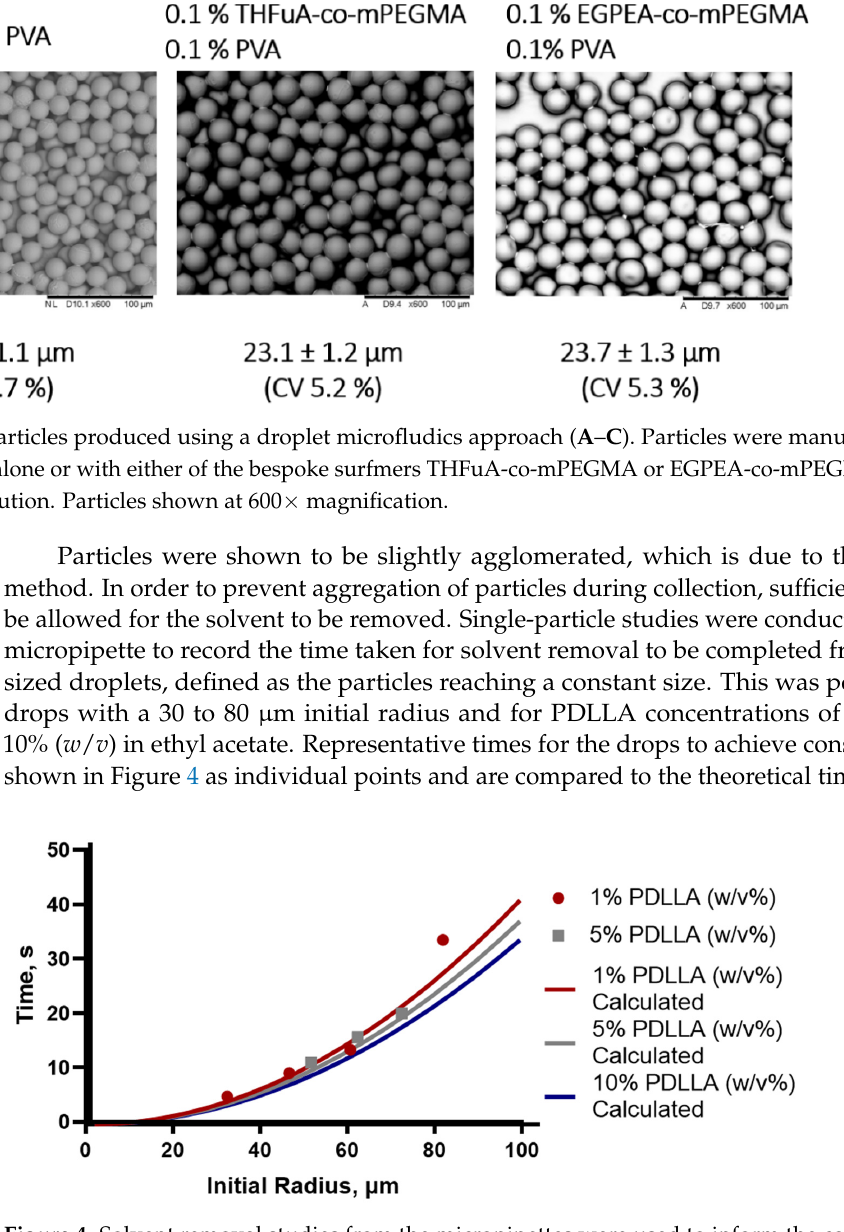
Figure 4. Solvent removal studies from the micropipettes were used to inform the collection vessel properties to reduce aggregation. The estimated time for solvent to be removed from drops of increasing size and concentration of PDLLA was calculated using a modified Epstein–Plesset model and shown by the red, grey and blue lines for 1%, 5% and 10% ( w / v ) PDLLA, respectively. The results of representative drops are shown in corresponding colours using circles and squares for 1% and 5% ( w / v ), respectively.